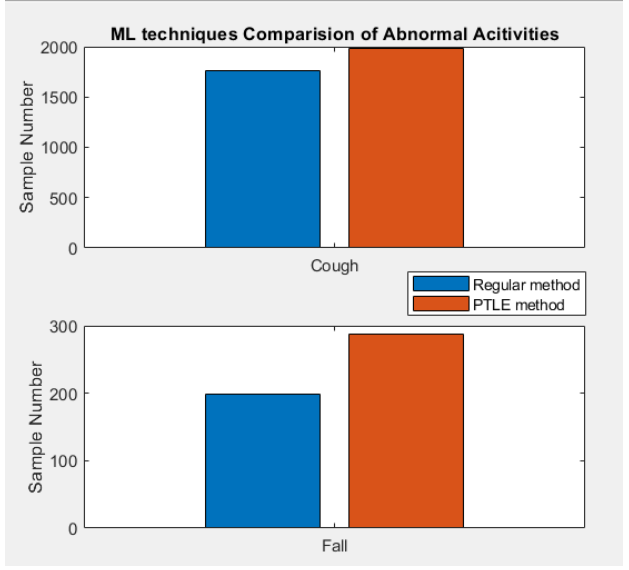
Figure 10. Correct prediction from the two methods in abnormal activities .